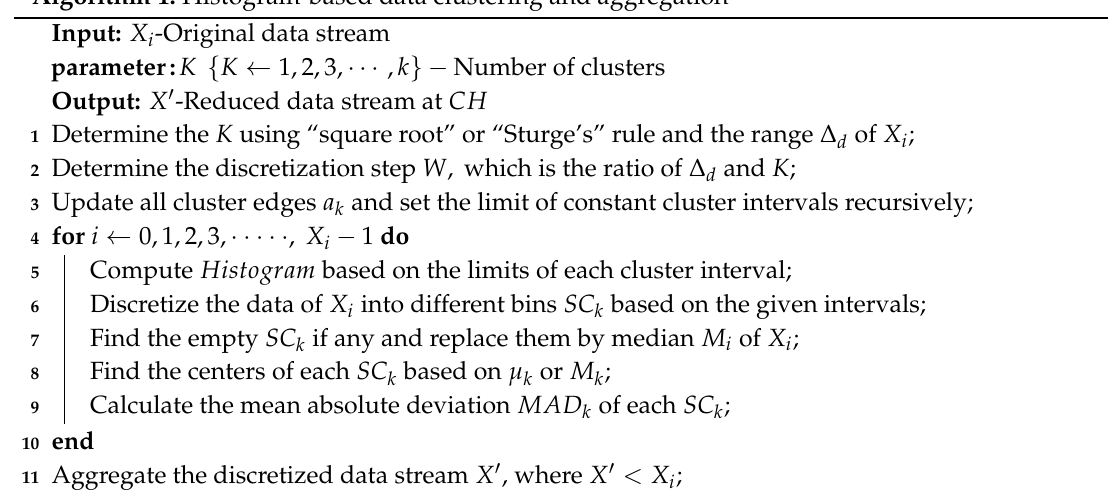
Algorithm 1: Histogram-based data clustering and